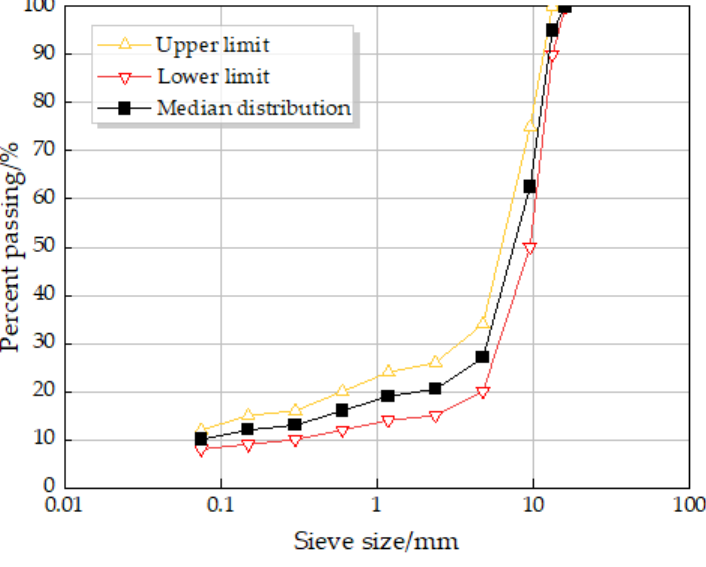
Figure 2. Aggregate gradations of investigated